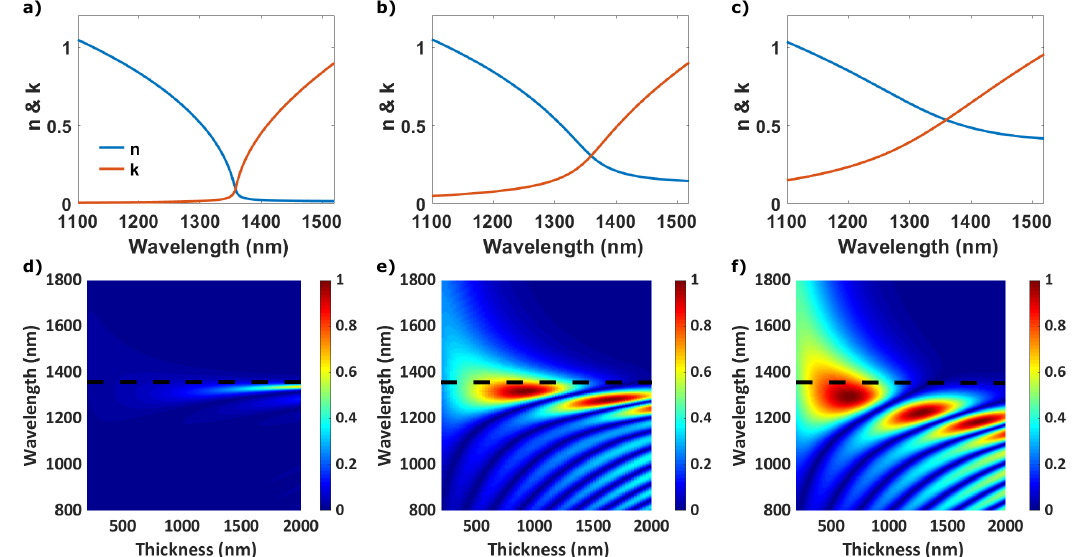
Figure 2. ( a – c ) Real and imaginary part of the refractive index of the three cases with λ ENZ ≈ 1350 nm. ( d – f ) Normalized visibility of the total energy as a function of the wavelength for different thicknesses. The dashed red line indicates the λ ENZ . For the dispersion we use (cid:101) ∞ = 3.18 and ω p = 2.4745 × 10 15 rad/s. For the damping constant we use γ a = 1.0073 × 10 13 , γ b = 0.8053 × 10 14 and γ c = 2.3614 × 10 14